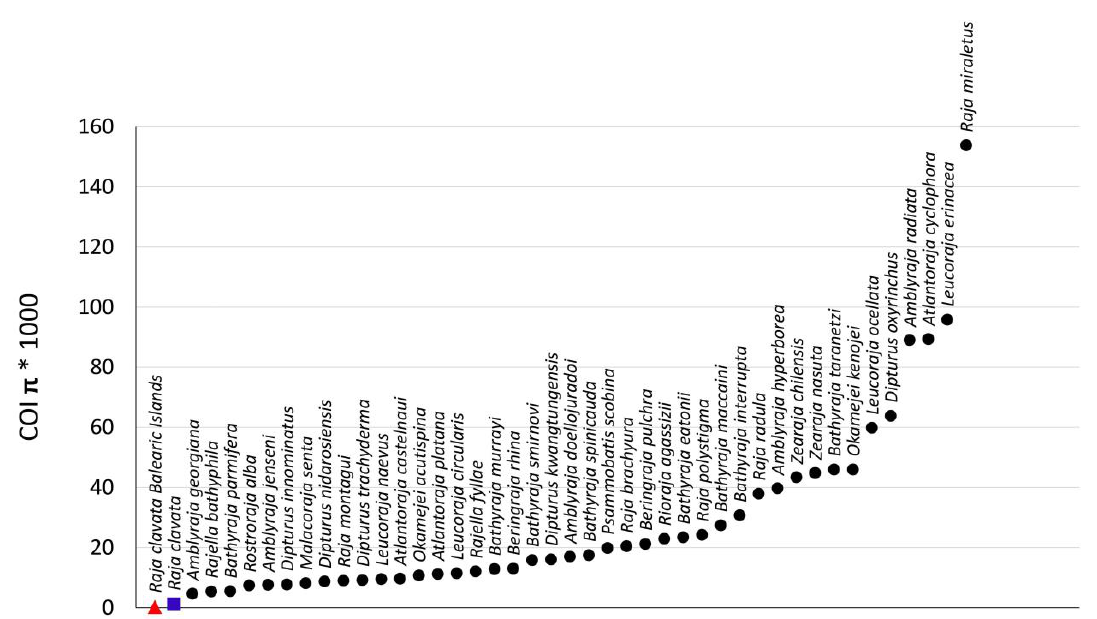
Figure 5. Levels of genetic diversity for the COI fragment (Cytochrome C Oxidase subunit I) mito- chondrial gene (COI π ) of Rajiformes species (black dots), Raja clavata global population Atlantic- Mediterranean (blue square) and Raja clavata in the Balearic Islands (red triangle). Species were ordered by their levels of COI π ; these were multiplied by 1000 for graphical purposes.